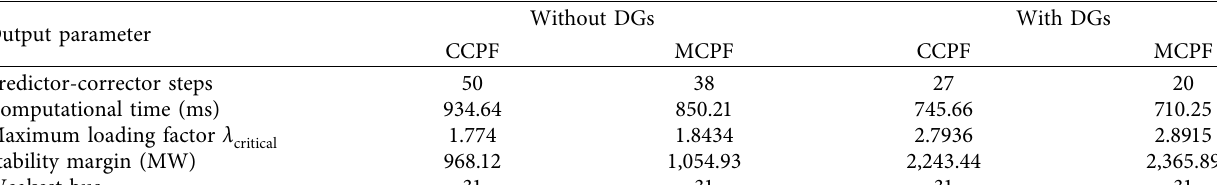
Figure 8: The P-V curve at bus 31 during the load-increasing process: (a) without DG; (b) with Table 3: Comparisons between CCPF and MCPF of the IEEE 57-bus test system.